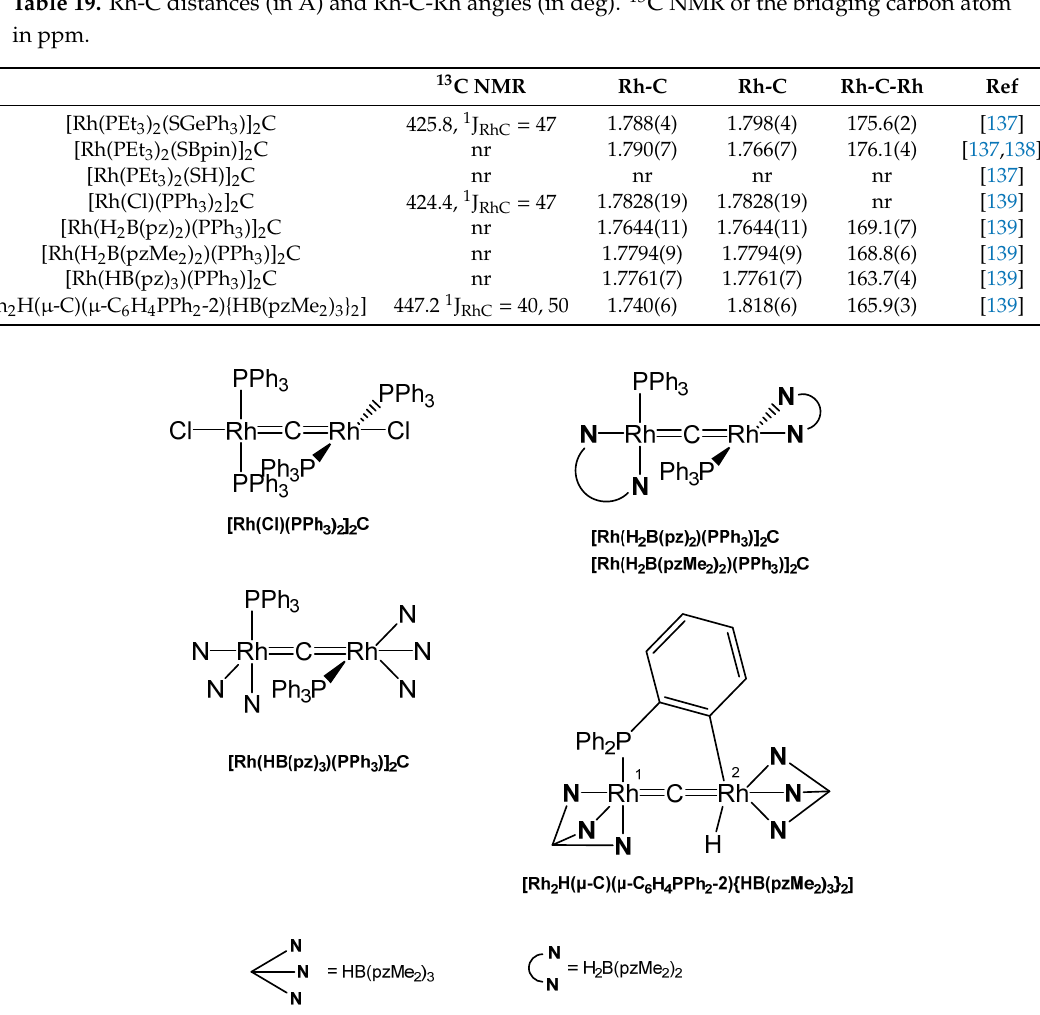
Figure 35. Selected structures of Rh = C = Rh complexes.